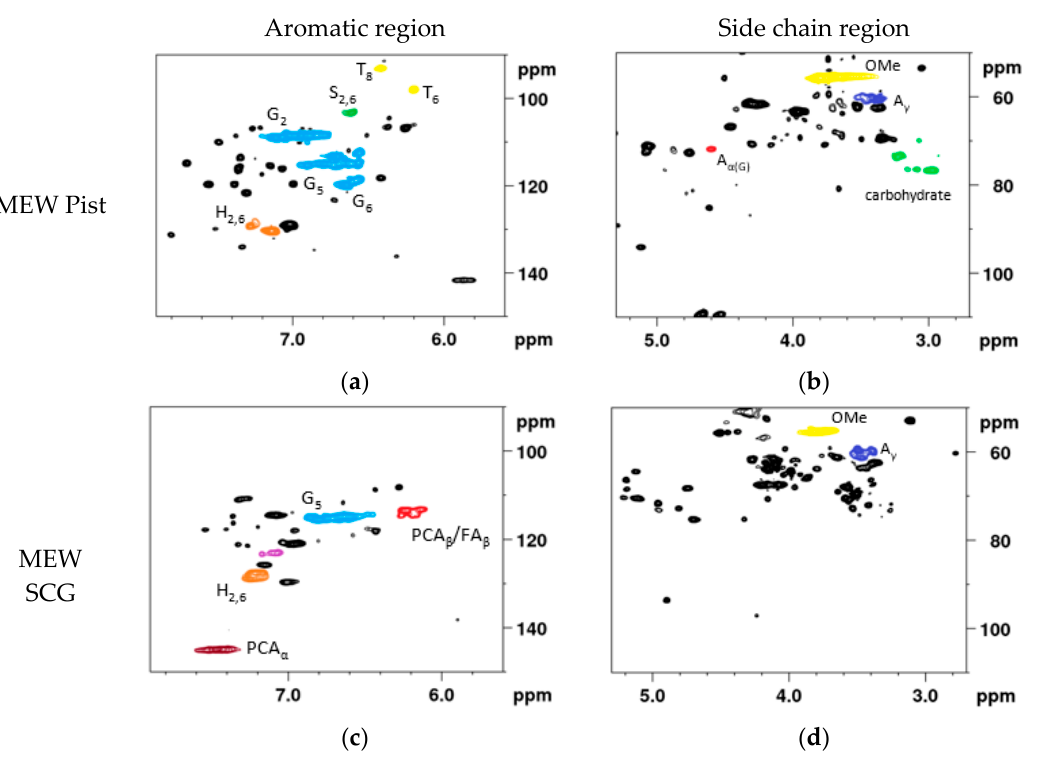
Figure 6. A 2D NMR analysis of LEF samples obtained using MW. See Table 5 for label assignments.